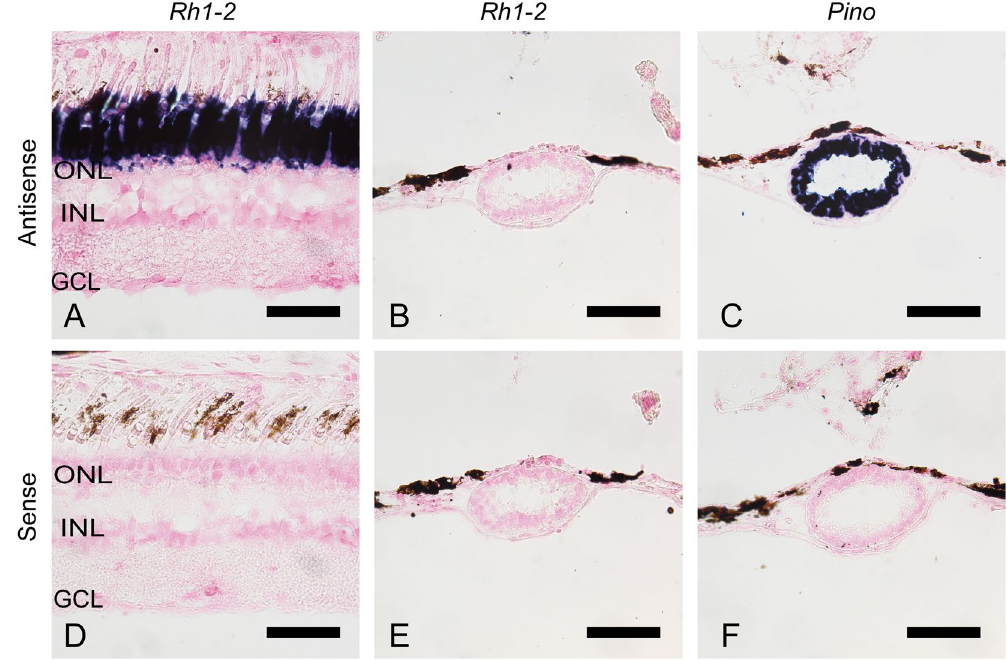
Figure 4. Distribution of rhodopsin in the retina and the pineal gland of Siberian sturgeon. In situ hybridization of rhodopsin ( Rh1-2 ) and pinopsin ( Pino ) in the retina and the pineal gland of Siberian sturgeon. The section of the retina was hybridized with antisense probe of Rh1-2 ( A ). The frontal sections of the pineal gland were hybridized with antisense probes of Rh1-2 ( B ) and Pino ( C ), respectively. ( D–F ) show the consecutive tissue sections to ( A – C ) hybridized with corresponding sense probes, respectively. All the sections shown in this figure were counterstained with Nuclear Fast Red. Scale bar: ( A , D ) 50 μ m; ( B , C , E , F ) 100 μ m. ONL, outer nuclear layer; INL, inner nuclear layer; GCL, ganglion cell